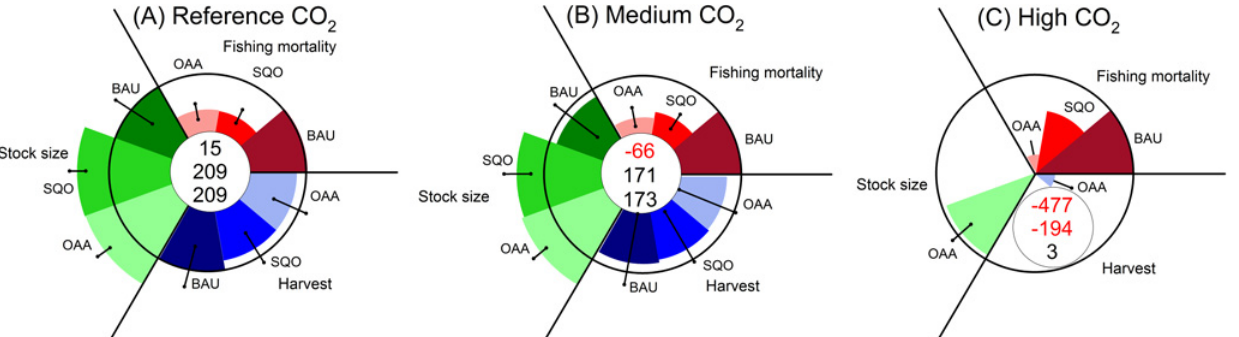
Fig 2. Summary of management options and trade-offs under increasing ocean acidification. Business as usual (BAU), Status Quo Optimum (SQO) as well as Optimal Adaptation to Acidification (OAA — see text for explanation) for 3 levels of ocean acidification. (A) Reference CO2. (B) Medium CO2 (1800 μ atm). (C) High CO2 (4200 μ atm). Central numbers indicate total profits (million USD/year) for BAU, SQO and OAA management (top to bottom). Area of each pie slice is relative to business as usual, quasi sustainable values 2000 – 2012 (black circle), with error bars from sensitivity analysis.